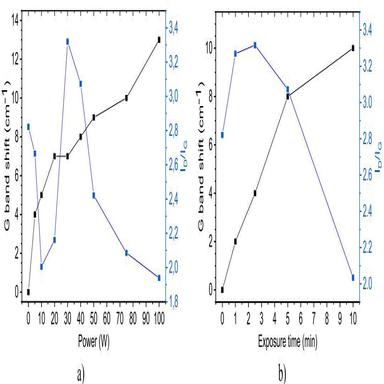
Dependence of the G band shift (black) and the ID/IG area ratio on a) the applied power (t = 5 min); b) the exposure time (P = 40 W) for O2 plasma-treated CF.